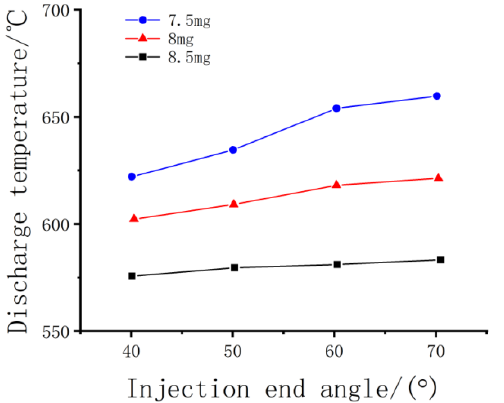
Figure 39. Effect of the injection parameters on exhaust temperature.